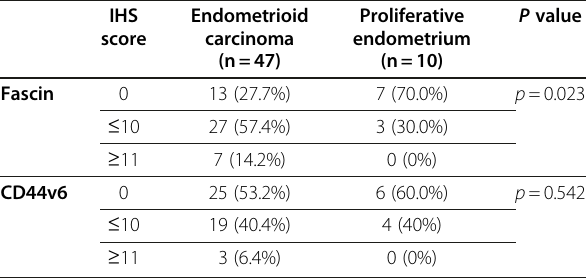
Table 1 Comparison of cases with endometrioid